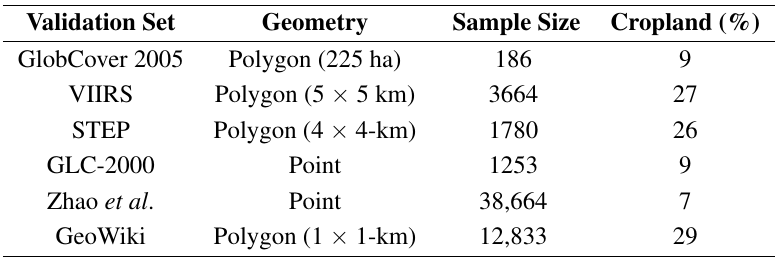
Table 2. Validation datasets collected, their geometries and the percentage of cropland samples. VIIRS, Visible Infrared Imaging Radiometer Suite; STEP, System for Terrestrial Ecosystem